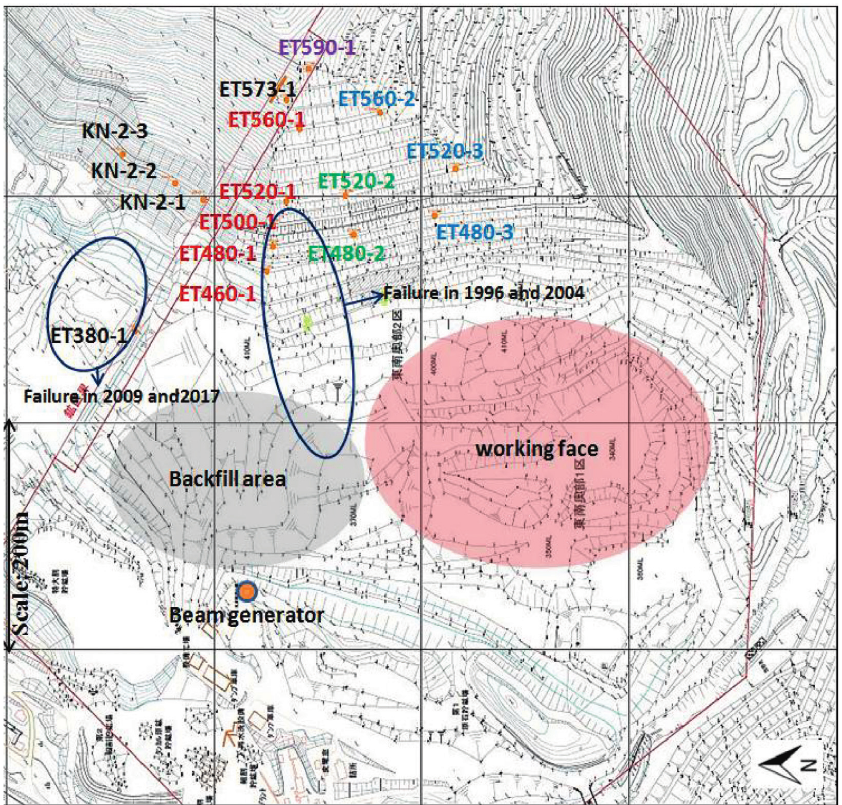
Figure 6: Map showing the APS at the quarry. The ETrepresents the mirror point locations of the automated polar system (APS) set on the rock slope. Each mirror point is represented with a number that indicates its level of